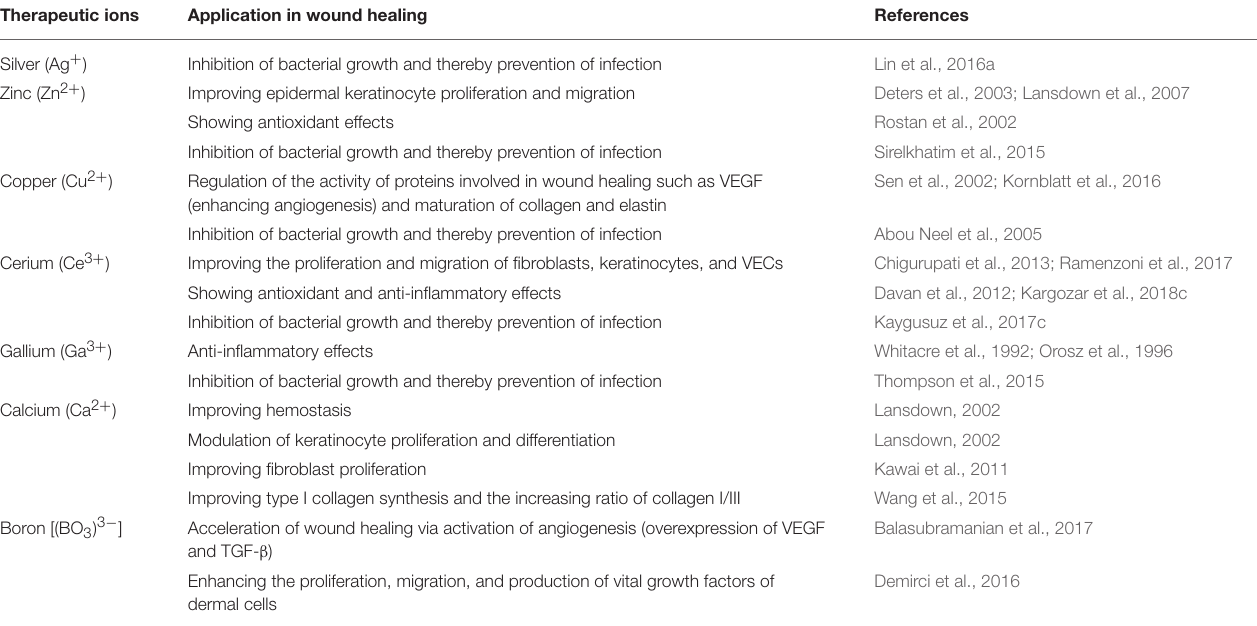
TABLE 2 | Therapeutic ions useful for soft tissue healing